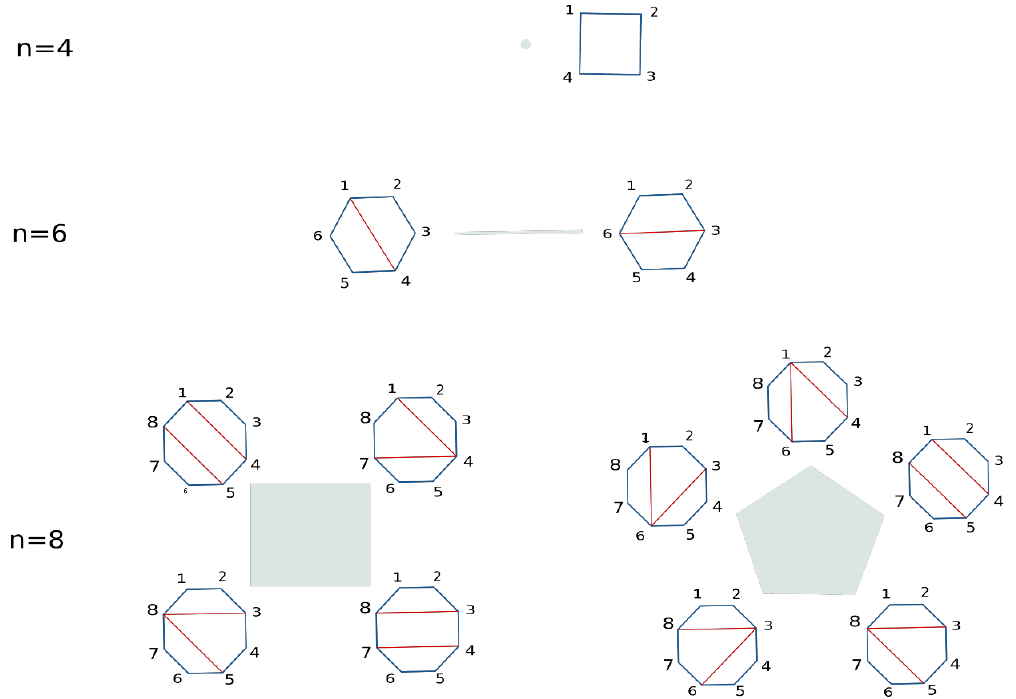
Figure 10 . The first few Stokes polytopes. Note that for n = 8 there are two kinds of polytopes. This is one of the key features of the quartic